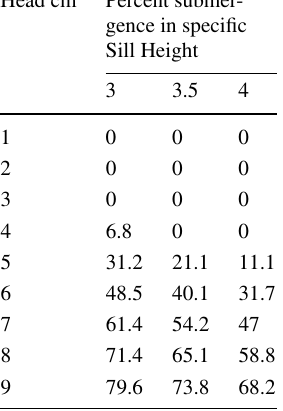
Table 2 Percentage of immersion in different depths of water (Head) at different heights of flume floor from furrow (sill